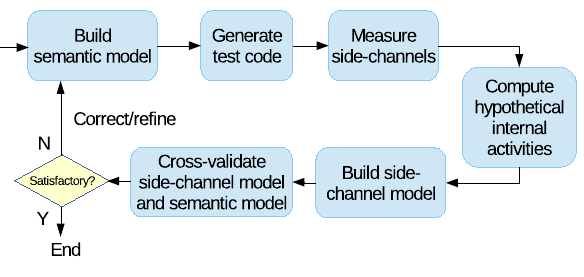
Figure 1. Side-channel profiling a black-box